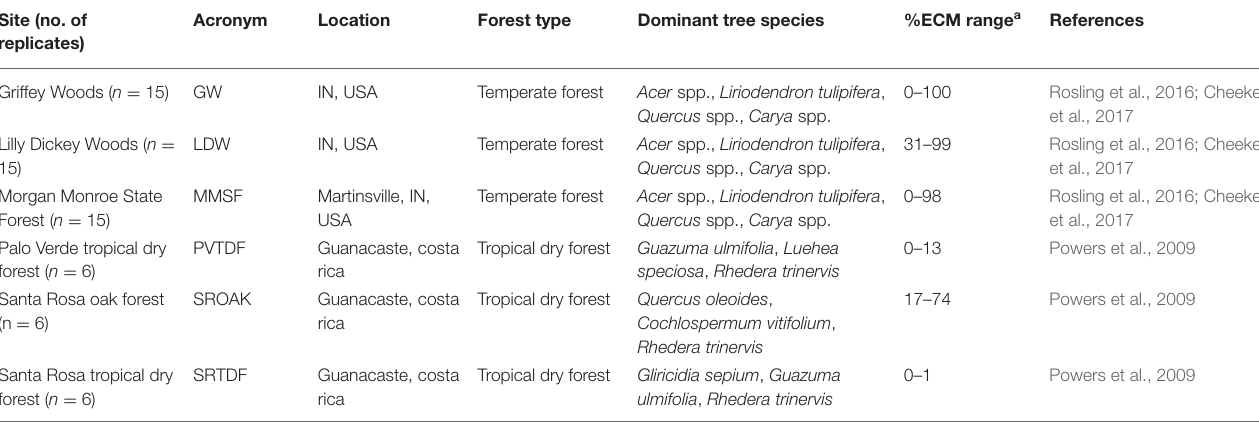
TABLE 1 | Validation data site